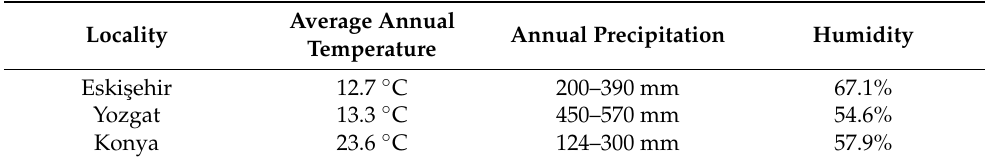
Table 1. Meteorological characteristics of each region during the 2017–2018 growing season.